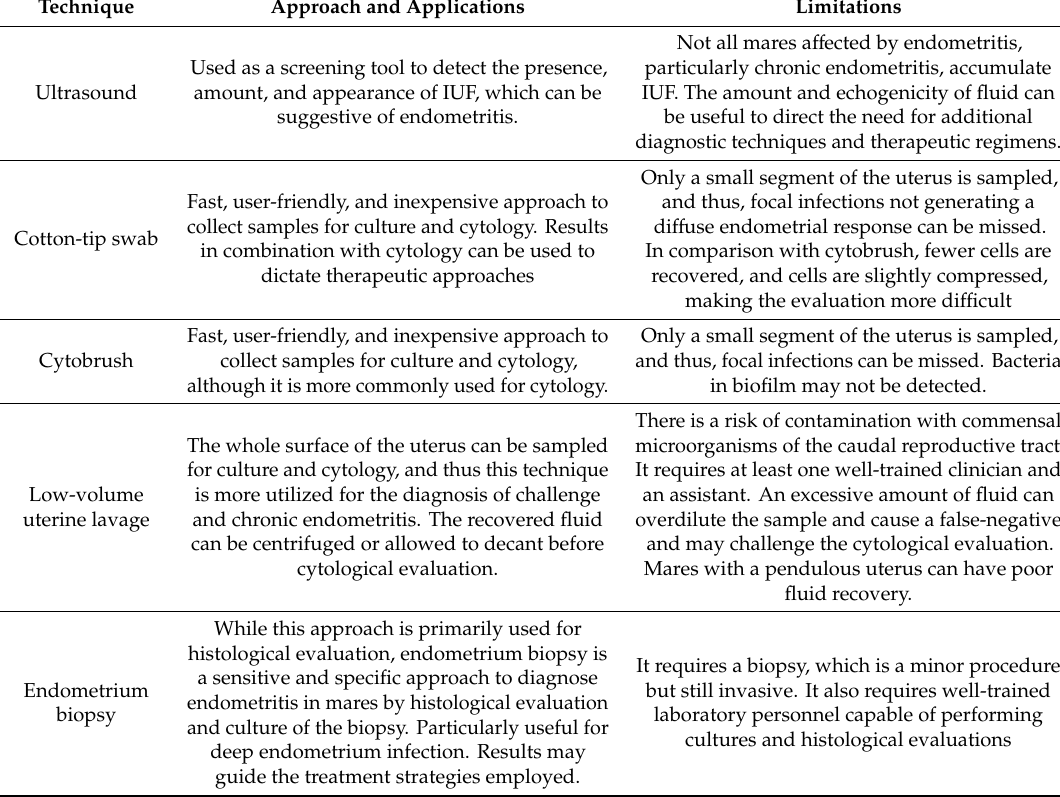
Table 2. Summary of common tools used to diagnose endometritis in